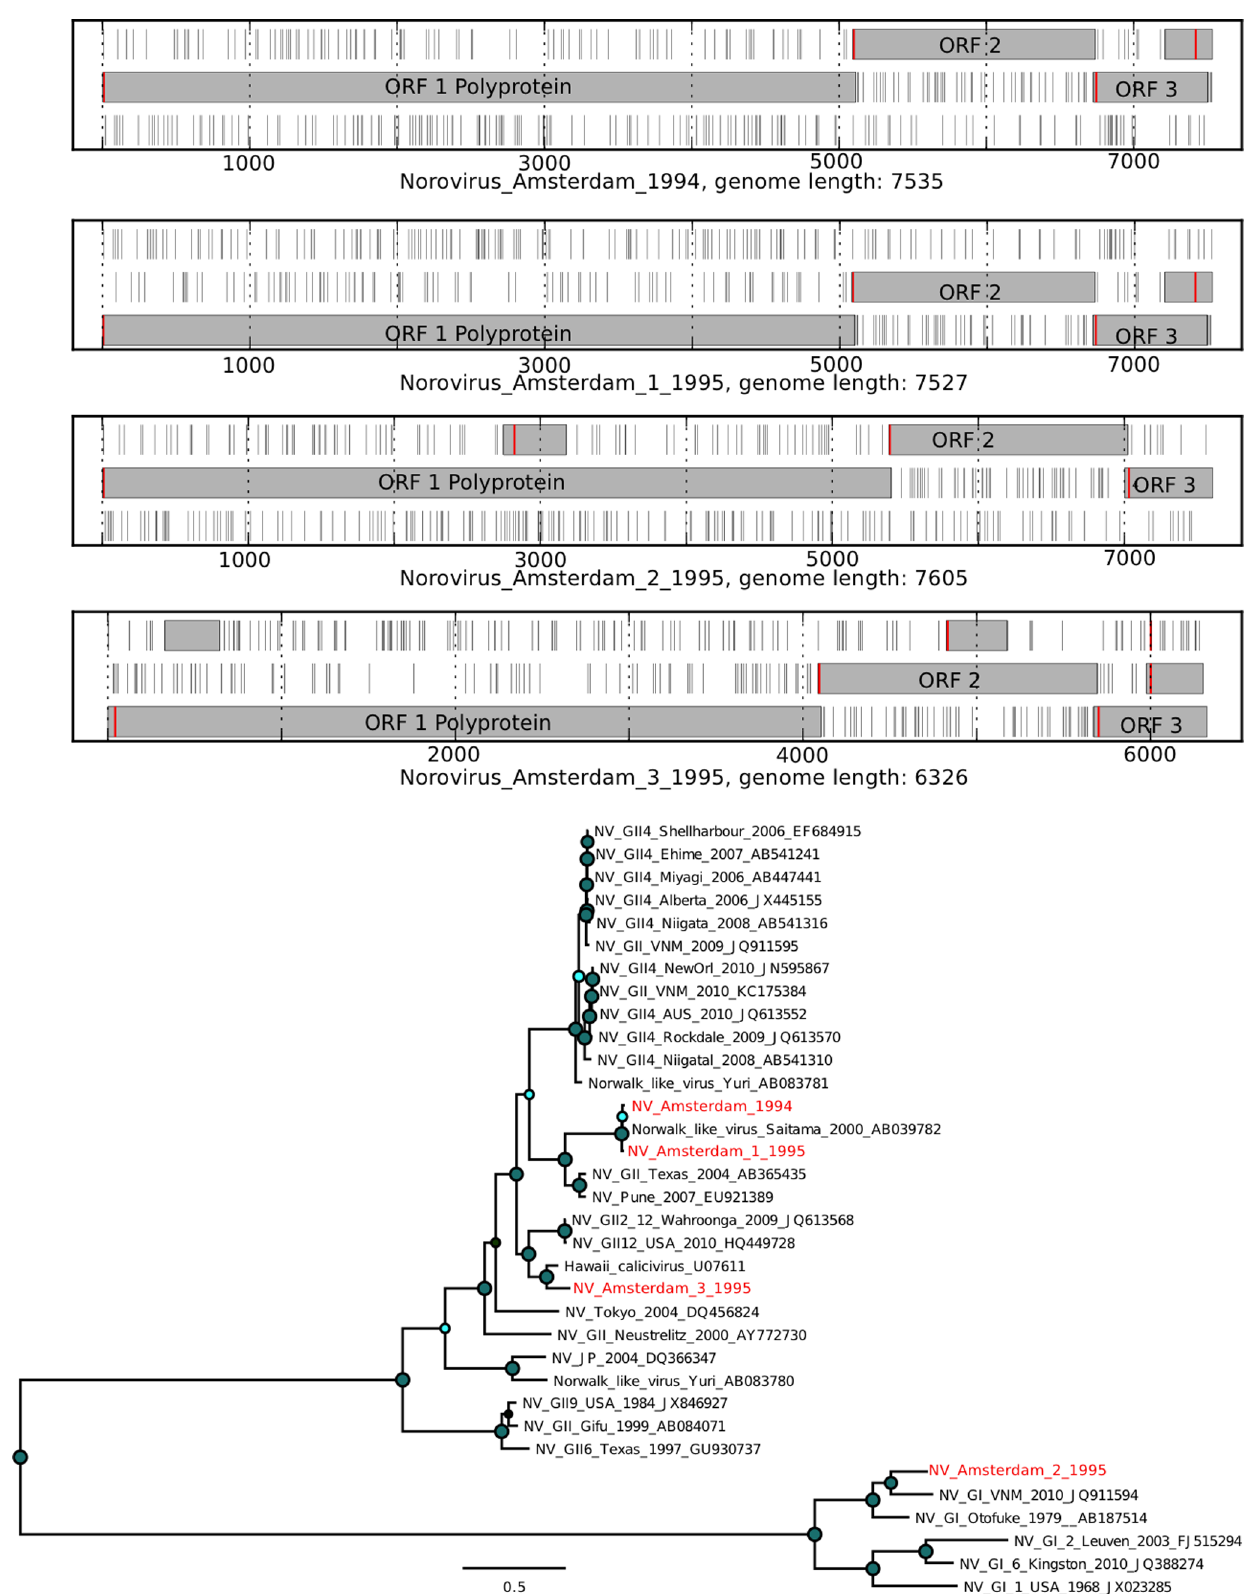
Figure 11. Open reading frame structure and phylogenetic analysis of the norovirus genomes identified in this study. Analysis and graphical presentation was performed as described in the legend to Figure 7.